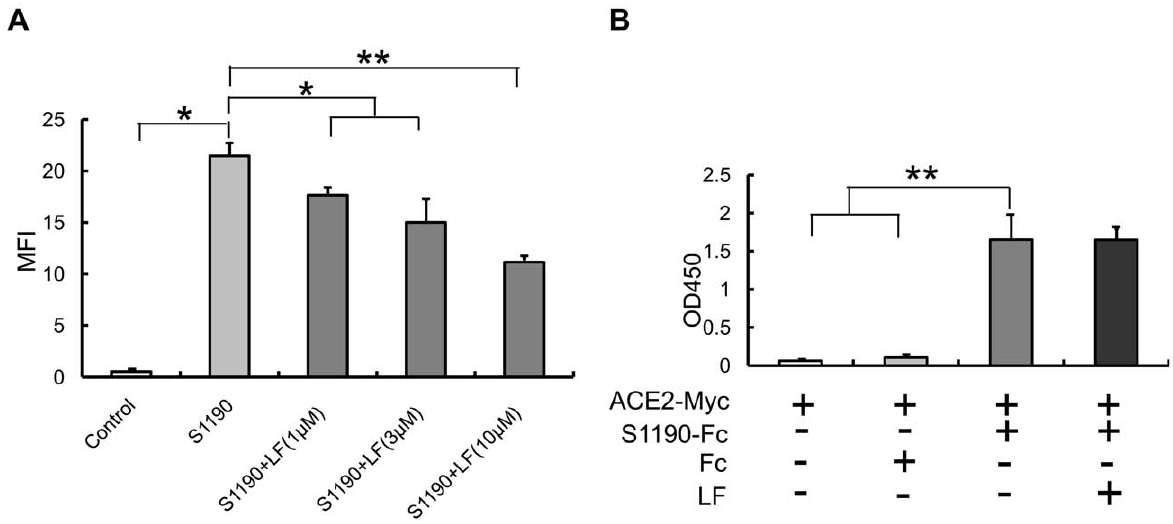
Figure 2. Lactoferrin blocks the interaction between spike protein and HEK293E/ACE2-Myc cells in an ACE2-independent fashion. ( A ) LF inhibits the binding of S1190-Fc to HEK293E/ACE2-Myc cells. Before incubation of S1190-Fc with HEK293E/ACE2-Myc cells at 4 u C for 1 h, the cells were treated with LF at 37 u C for 1 h at concentrations of 1 m M, 3 m M and 10 m M. Fc protein was used as a control. S1190-Fc binding to the cells was detected by flow cytometry as described in Methods. Error bars represent the SD of three independent experiments. ***P , 0.001, **P , 0.01 and *P , 0.05. ( B ) LF does not disrupt the binding of S1190-Fc to ACE2-Myc. Error bars represent the SD of three independent experiments. ** P , 0.01.